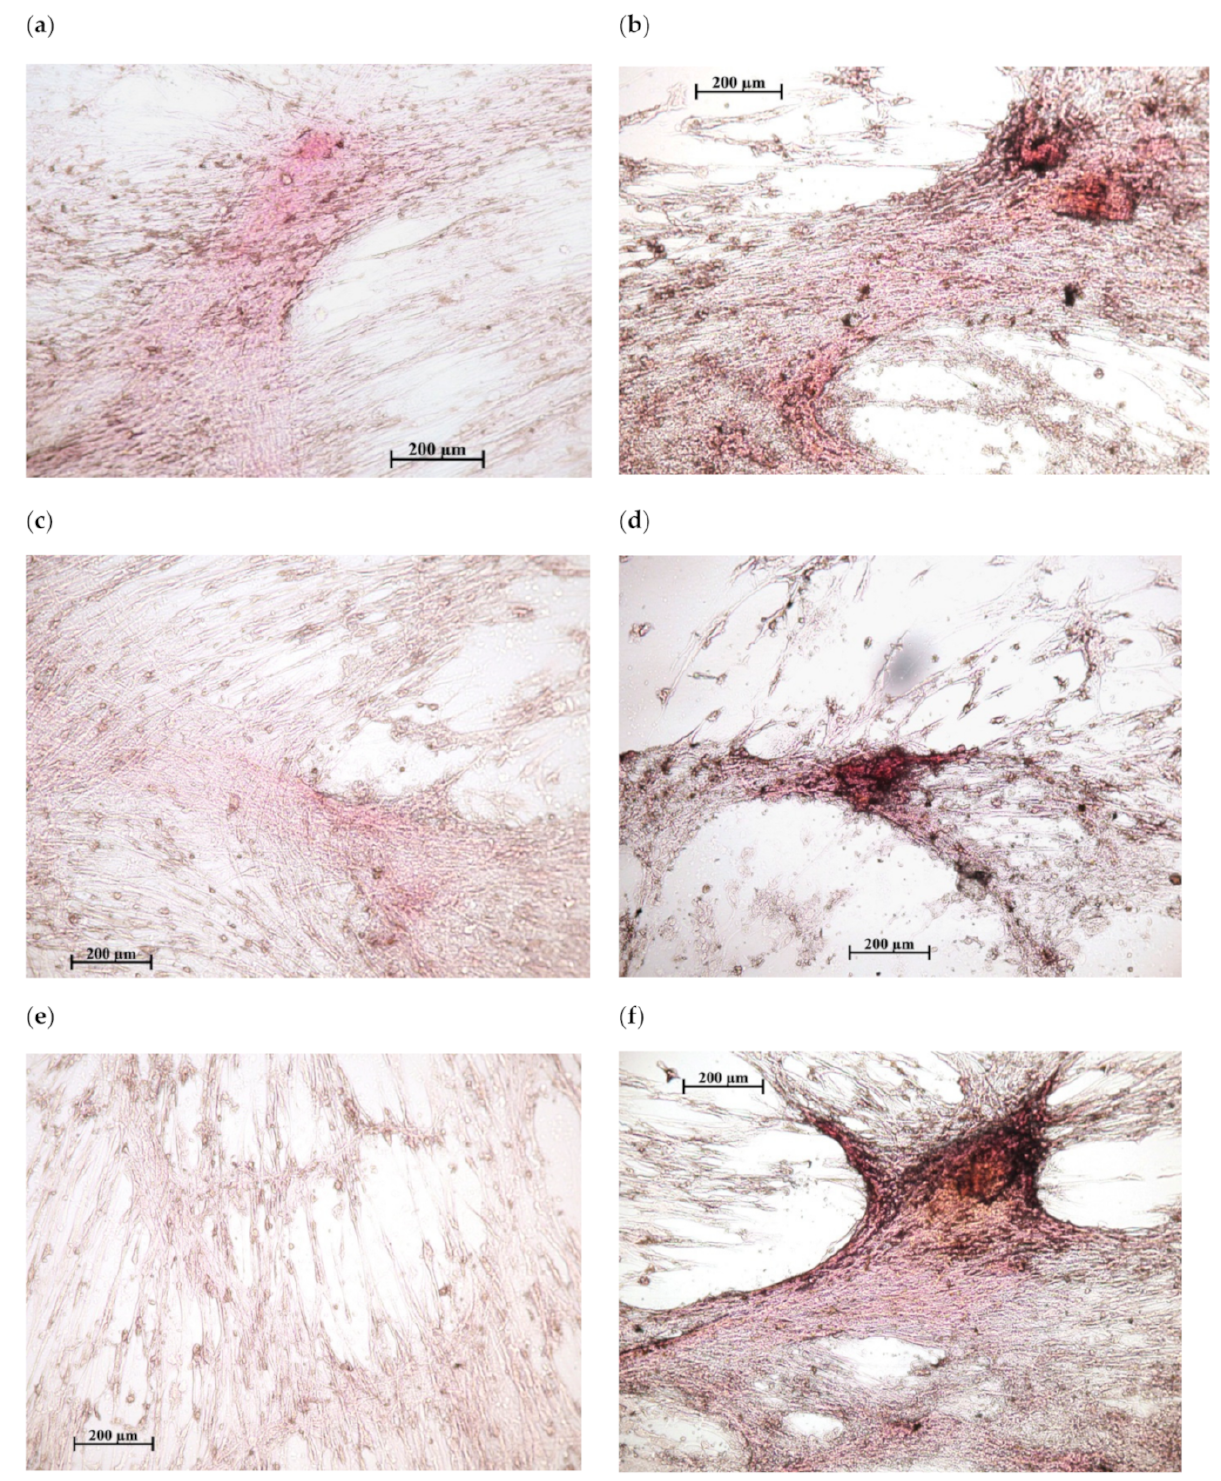
Figure 3. In vitro osteogenic differentiation of human adipose-derived multipotent mesenchymal stromal/stem cells after 21 days of culture in a standard nutrient medium: ( a , c , e )—variants of poor diffuse coloring in control culture (addition of water solvent); ( b , d , f )—mineralization nodules after the addition of 10 mg/L of CaChA in water solution. Staining with alizarin red S. Magnification × 200. Scale bars 200 µ